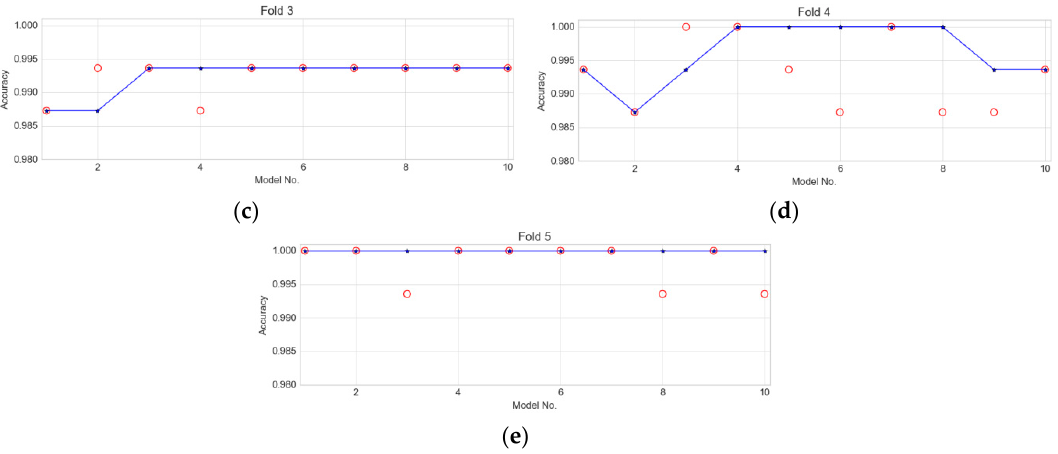
Figure 11. Accuracy of the ensemble model vs. single model. The red circles show accuracy of the single models and the blue stars and curve show accuracy of the ensemble model: ( a ) Fold 1; ( b ) Fold 2; ( c ) Fold 3; ( d ) Fold 4; ( e ) Fold 5.